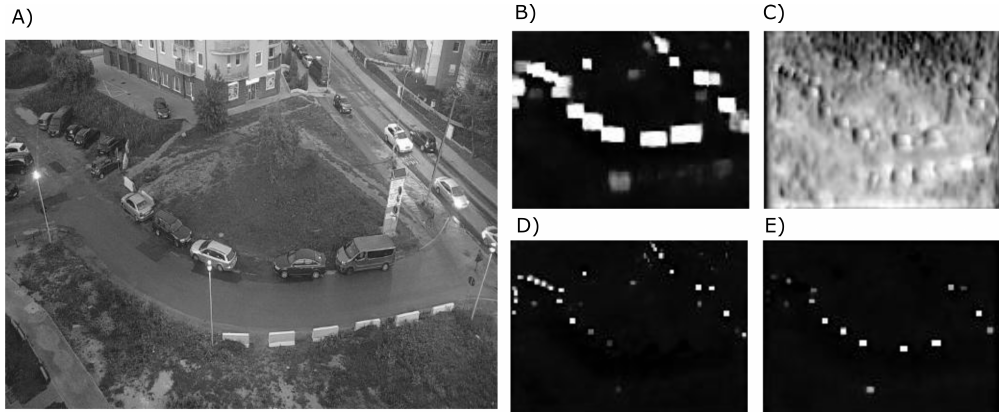
Figure 3. Example of detection input ( A ), and the output: heatmap ( B ), bounding box offsets ( C ), detection at scale 0 ( D ) and scale 1 ( E